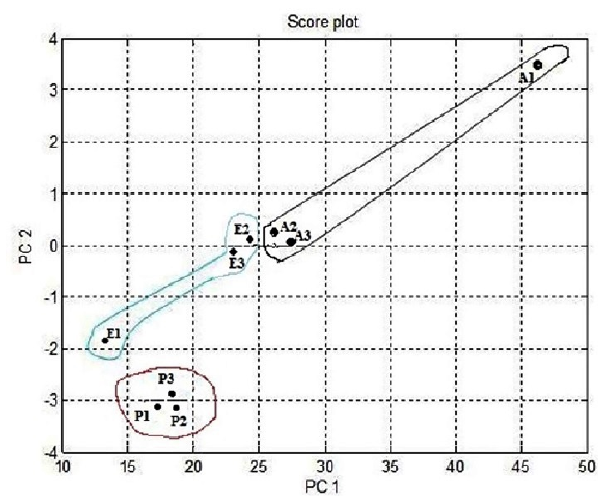
Figure 8. Multivariate technique on organic gases fractional feature notch design.